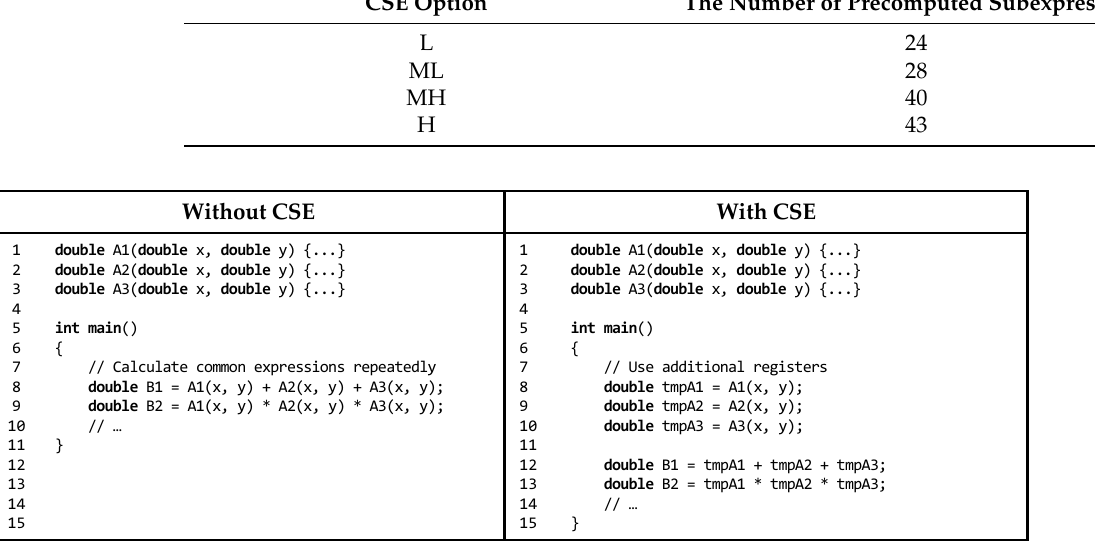
Figure 5. CSE implementation